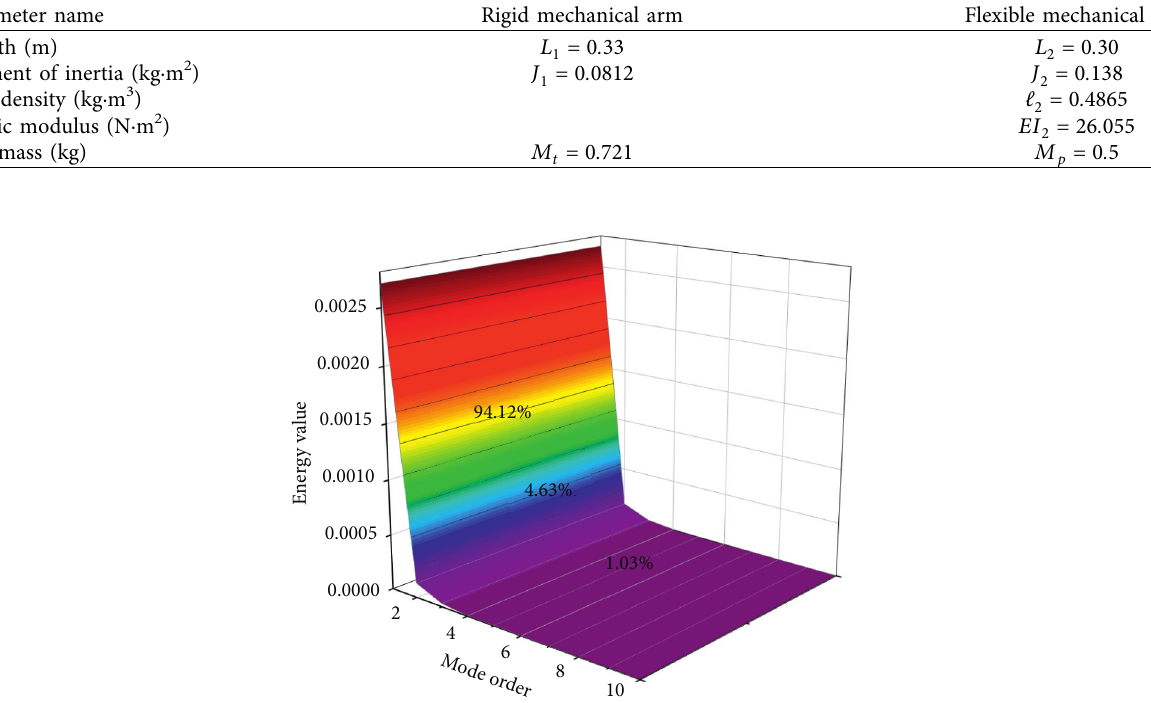
Figure 3: Relationship of modes and energy.